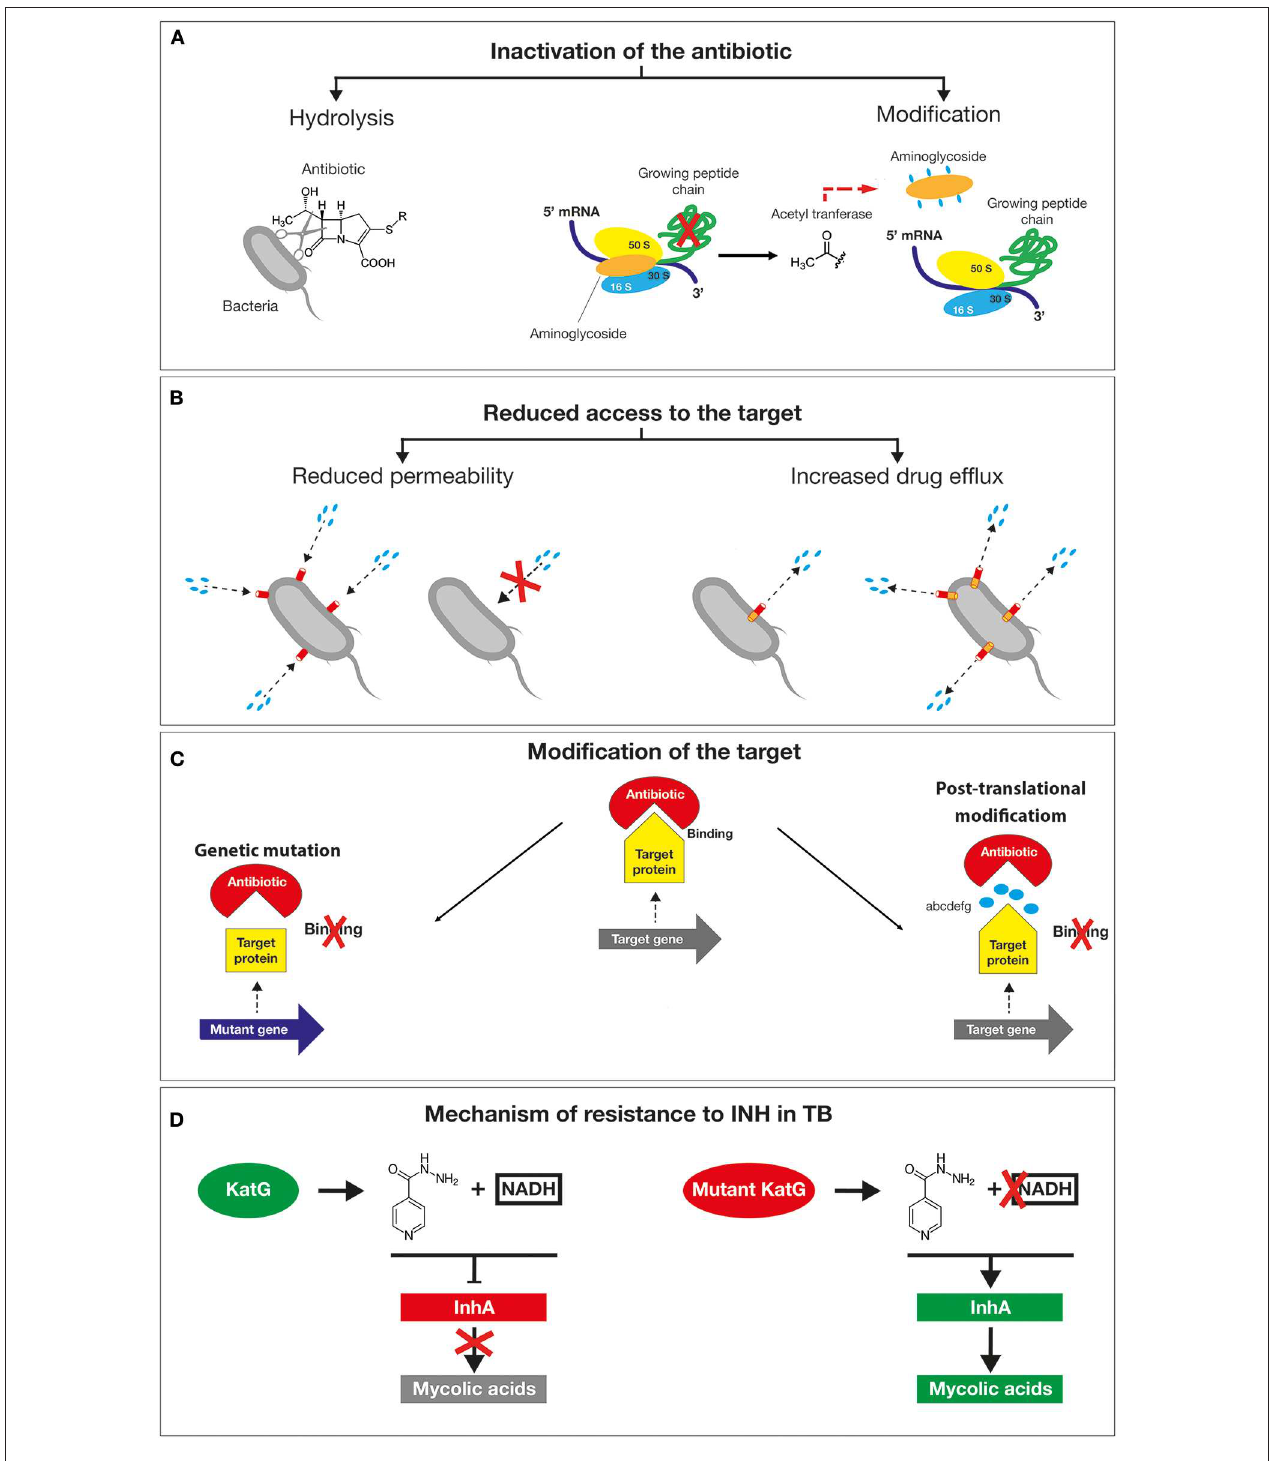
FIGURE 3 | Schematic representation of the main mechanisms exploited by bacteria to tackle the action of antibiotics. (A) The inactivation of the drug by its hydrolysis or structural modification. (B) The prevention of the access to the target by reducing membrane permeability or overexpression of efflux pumps. (C) Changes in the antibiotic targets by mutation or post-translational modifications. (D) Resistance mechanism of Mycobacterium tuberculosis to isoniazid drug mutations in the katG gene causes the accumulation of the inactive form of the antibiotic inside the bacilli without the formation of active adduct.